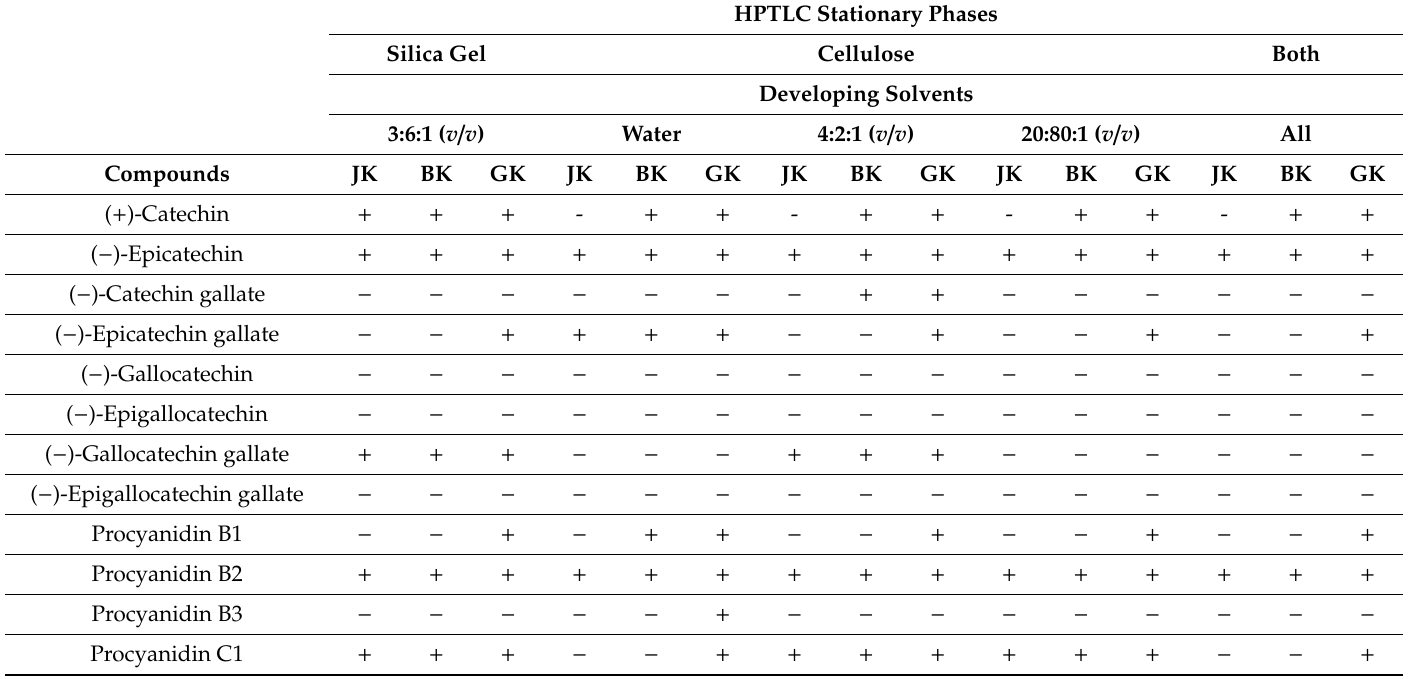
Table 1. Confirmation of presence of flavan-3-ols and proanthocyanidins based on matching of the R F values of standards and blue bands in tracks of STSs from leaves of Japanese (JK), Bohemian (BK) and giant (GK) knotweed on all HPTLC plates (silica gel and cellulose) developed with di ff erent developing solvents. The HPTLC silica gel plate was developed with toluene–acetone–formic acid (3:6:1, v / v ) [12], while HPTLC cellulose plates were developed using the following developing solvents: water [17–19] and 1-propanol-water-acetic acid in di ff erent ratios (4:2:1, v / v ; 20:80:1, v / v ) [19]. The final confirmation of compounds was only awarded to those which were detected using both stationary phases (column “Both” in Table 1) and all developing